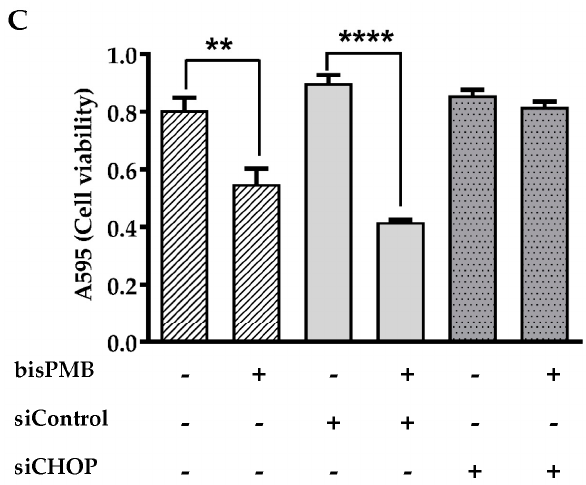
Figure 4. CHOP knock down reverses bisPMB cytotoxicity in WHCO1 cells. ( A ) Time-dependent CHOP expression. WHCO1 cells were incubated with bisPMB (IC 50 concentration) for 24 h. Total cell lysate was then extracted and examined for time-dependent CHOP protein expression by immunoblot probed with anti-CHOP and anti-GAPDH primary antibodies. ( B ) Knock-down of CHOP. WHCO1 cells were pre-incubated with siRNA-CHOP or vehicle for 6 h followed by addition of bisPMB (IC 50 concentration) for 24 h. Total cell lysate was extracted and examined for CHOP protein expression by immunoblot probed with anti-CHOP and anti-GAPDH primary antibodies. ( C ) Cell viability quantification. WHCO1 cells were pre-incubated with siRNA-CHOP or vehicle for 6 h followed by addition of bisPMB (IC 50 concentration) for 24 h. Cell viability was then quantified by the MTT assay. Each column represents an average of three technical replicates and the graphs are representative of three independent experiments. Student t -test indicates ** p -value < 0.01; **** p -value < 0.001.